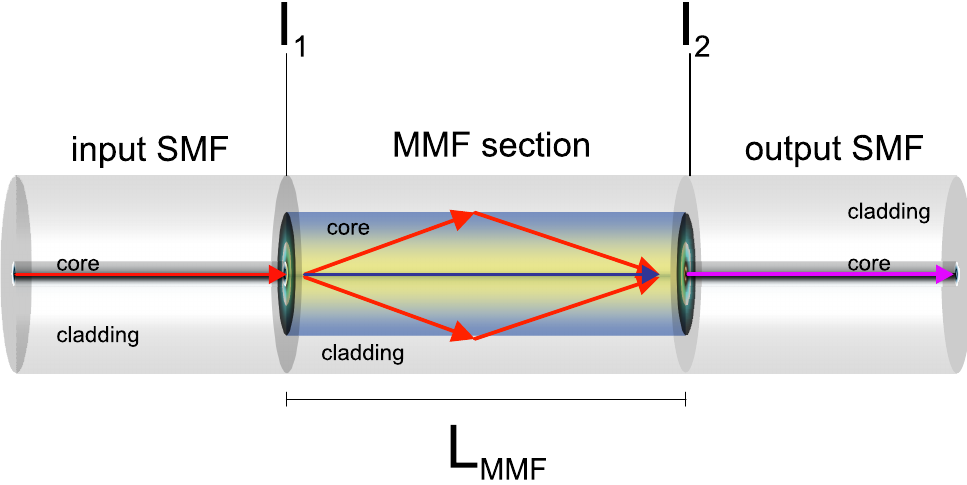
Figure 1. Schematic of the MMI sensor based on the core diameter mismatch